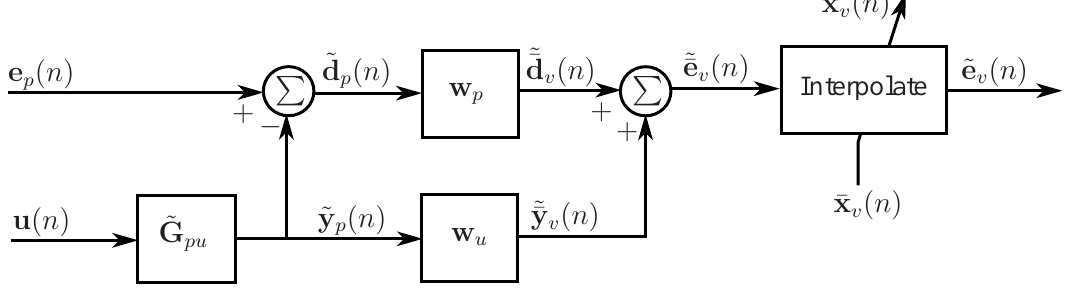
Figure 11 . Block diagram of the adaptive LMS moving virtual microphone